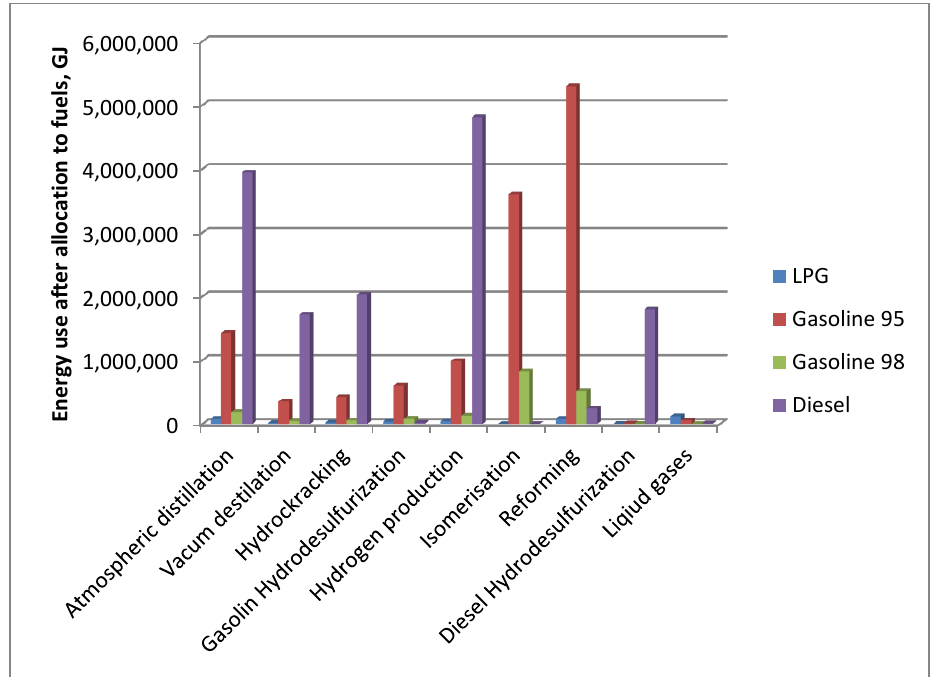
Figure 3. Annual GHG emissions generated by individual installations and motor fuels.